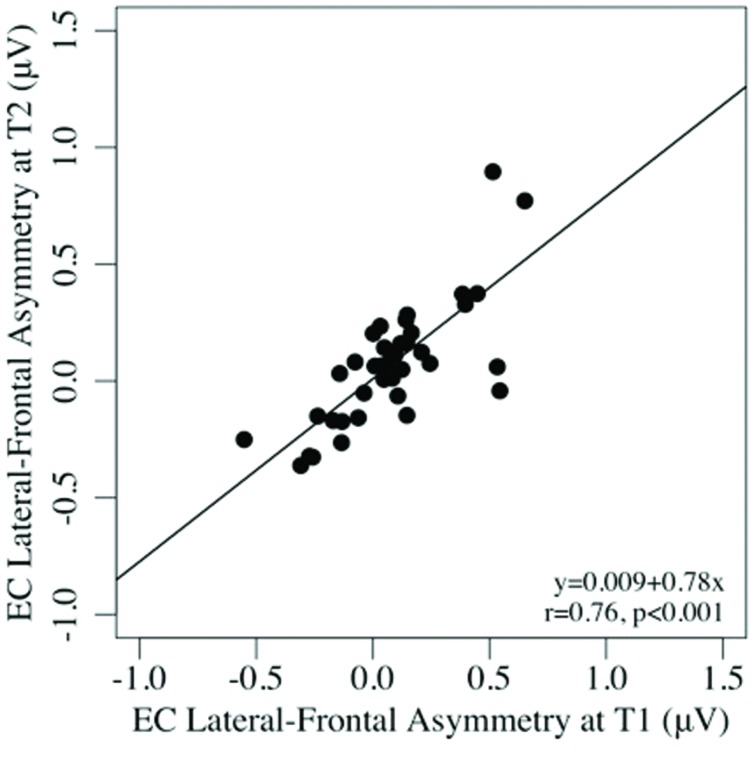
Scatterplots of the associations between lateral-frontal asymmetry in the eyes-closed, pre-task (T1), and post-task (T2) conditions.